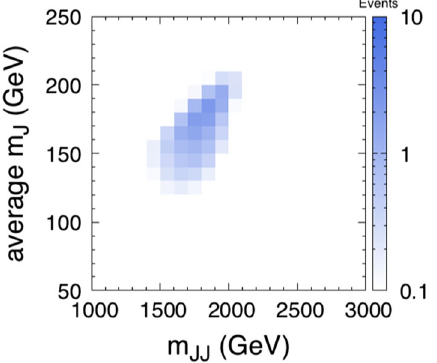
Fig. 9 Two-dimensional distribution of the signal in the 2DT class, for the 2 TeV benchmark (1) b tagging of sub-jets to divide the event sample into dif- ferent categories according to the number of b tags; (2) a generic jet substructure tagger that selects any type of multi-pronged